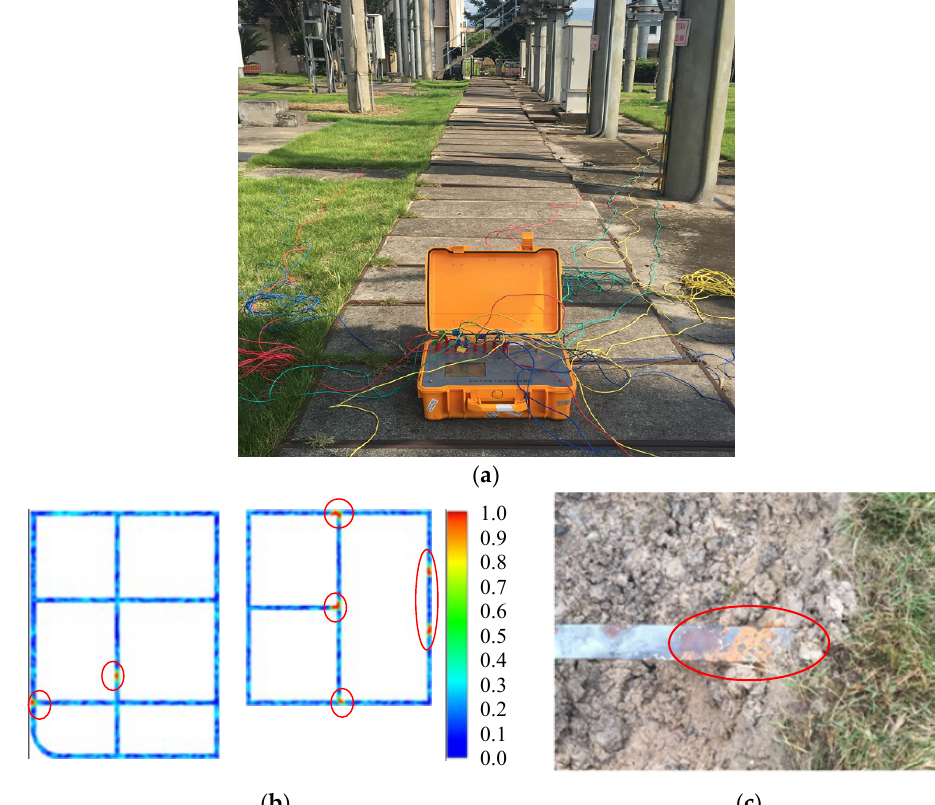
Figure 14. The experiment picture and imaging results on the field experiment, ( a ) the experimental setup; ( b ) the imaging results of block 1 and block 2; ( c ) one eroded branch dug from the block 2.